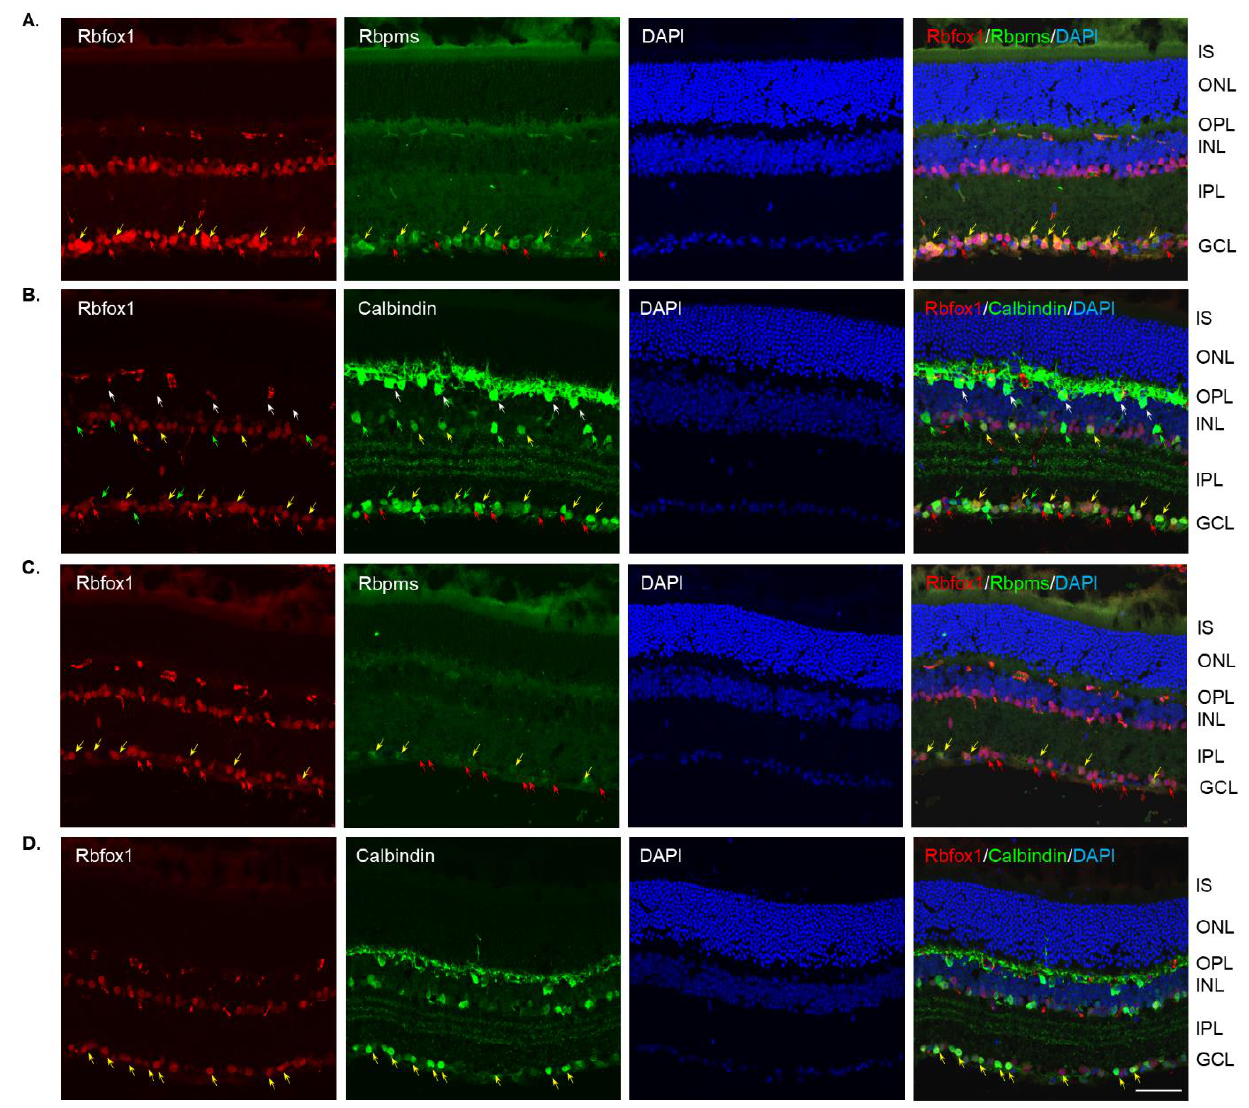
Figure 2. Expression of Rbfox1 in 22-month-old mouse retinas. As in young animals, Rbfox1 expression in the retinas of old mice was restricted to the cells within the GCL, which contains somas of RGCs and dACs in a ratio of approximately 1:1, and the innermost layer of INL, which is occupied by AC somas. ( A ) Virtually all Rbpms-labeled RGCs were also immunostained with Rbfox1 (pointed with yellow arrows). Some dACs in the GCL-Rbfox1-positive/Rbpms-negative cells–are pointed with red arrows. ( B ) Rbfox1 is expressed in the majority of calbindin-positive cells in the GCL (dACs and some RGCs express calbindin) and in the INL (ACs; yellow arrows). Rbfox1-negative dACs and ACs are pointed with green arrows. RGCs (Rbfox1 positive/calbindin negative) are indicated by red arrows. Antibodies against calbindin also stain HCs in the outmost layer of INL (adjacent to the OPL) are pointed with white arrows. ( C ) ONC resulted in significant loss of RGCs. Several remaining Rbpms/Rbfox1-positive cells are indicated by yellow arrows. Red arrows point at Rbfox1 positive dACs. ( D ) Most Rbfox1-positive cells in the GCL were also positive for calbindin, confirming that these cells are dACs (yellow arrows). A decrease in calbindin immunostaining intensity in retinas of ONC mice compared to that of uninjured animals was observed. IS, photoreceptor inner segments; ONL, outer nuclear layer; OPL, outer plexiform layer; INL, inner nuclear layer; IPL, inner plexiform layer; GCL, ganglion cell layer. Scale bar, 50 µm.